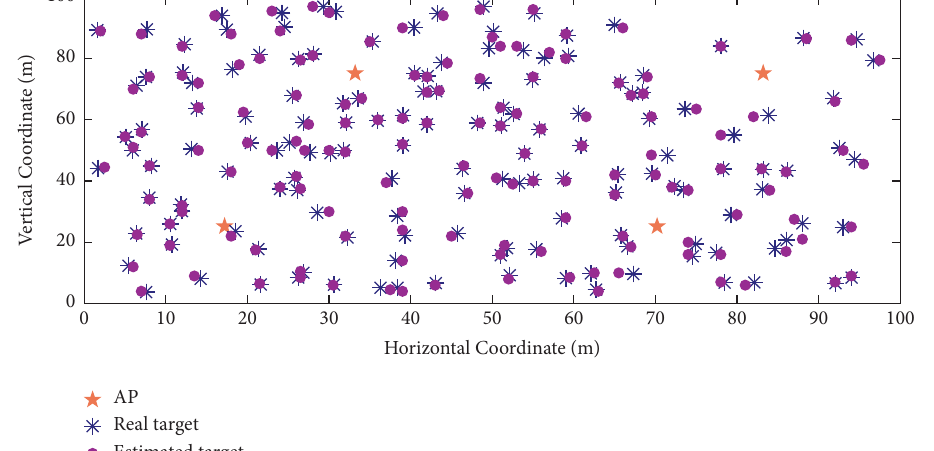
Figure 4: Positioning results of the proposed RSSD-PCA-PCC algorithm with 2 m grid distance, 4 APs, and K � 4.